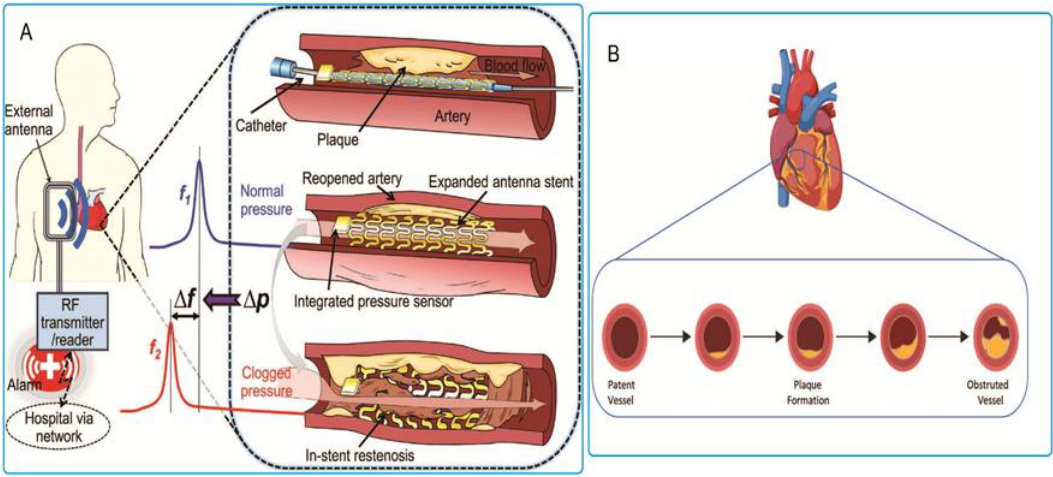
Figure 1. ( A ) Procedure of percutaneous coronary intervention (PCI) or coronary angioplasty. Reproduced with permission [6], Wiley’s Open Access; ( B ) elastic recoil and negative remodeling contribute to stenosis. Reproduced with permission [7], Wiley’s Open Access.